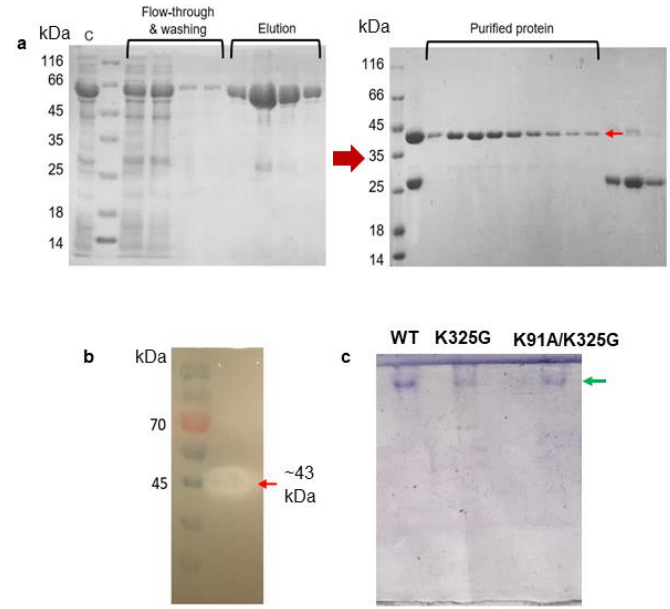
Figure 5. ( a ) SDS-PAGE (12%) analysis of two-steps purification of WT; ( b ) activity staining; and ( c ) native PAGE of purified WT, K325G and K91A / K325G. Symbols denote (C) crude enzyme, flow-through